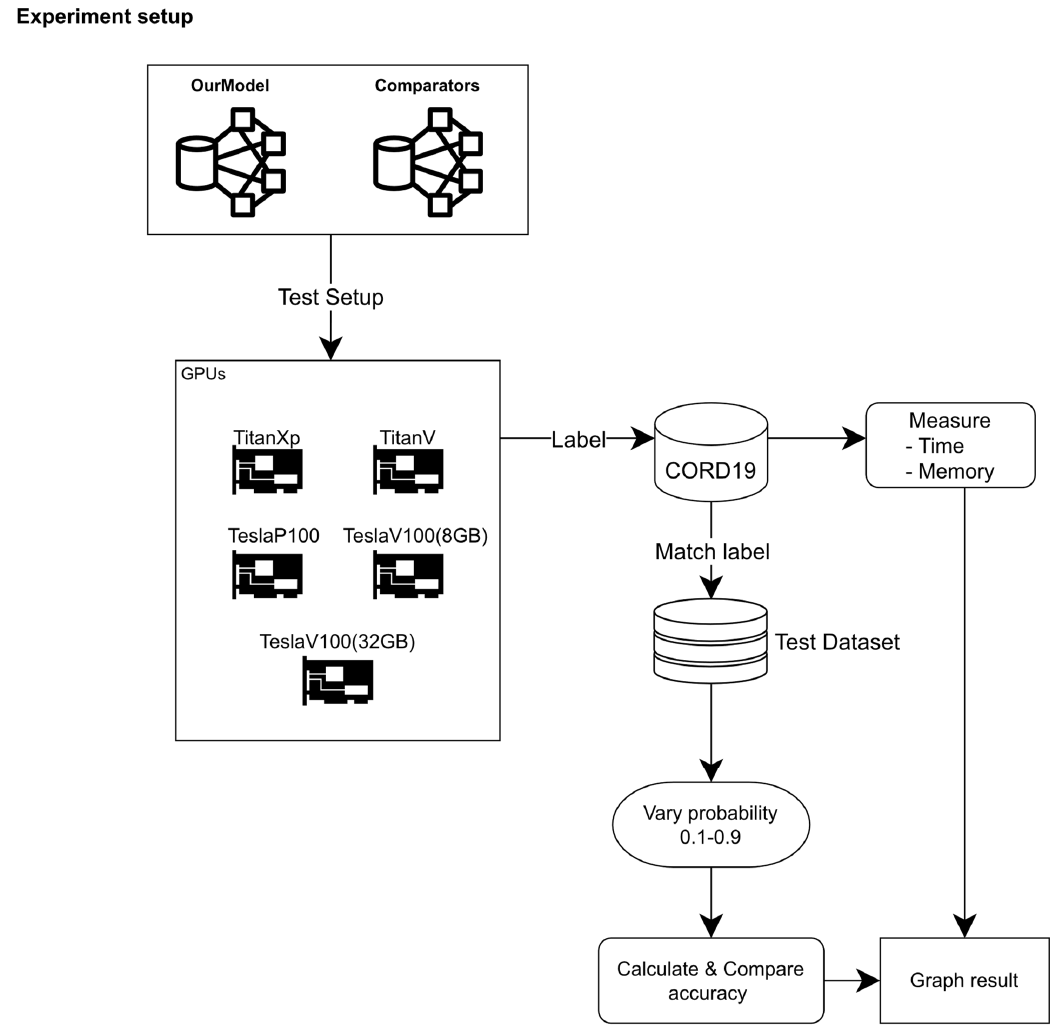
Figure 4. Experiment setup for our